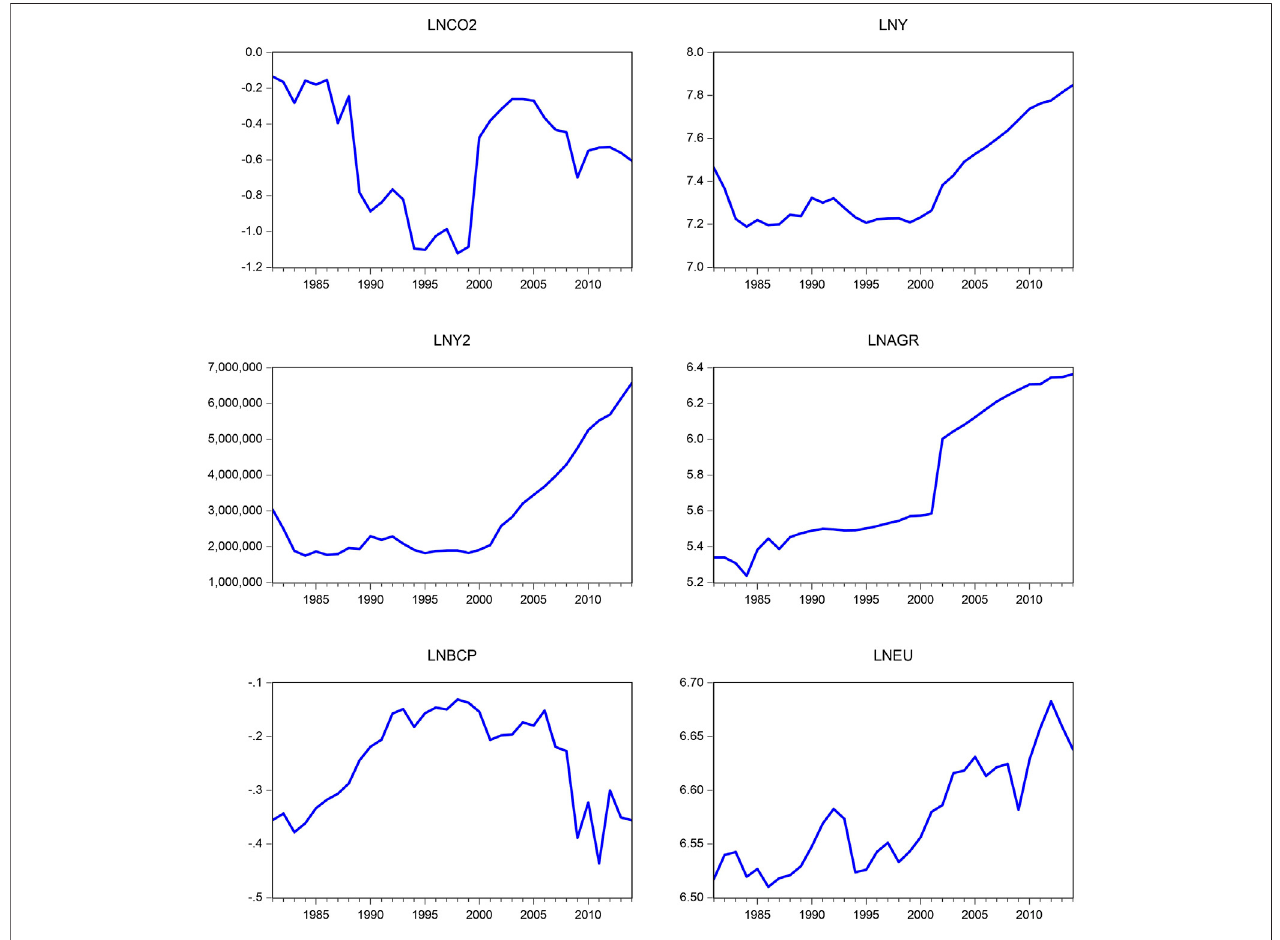
FIGURE 2 | Natural logarithms of CO 2 , Y, Y 2 , AGR, BCP, and EU.